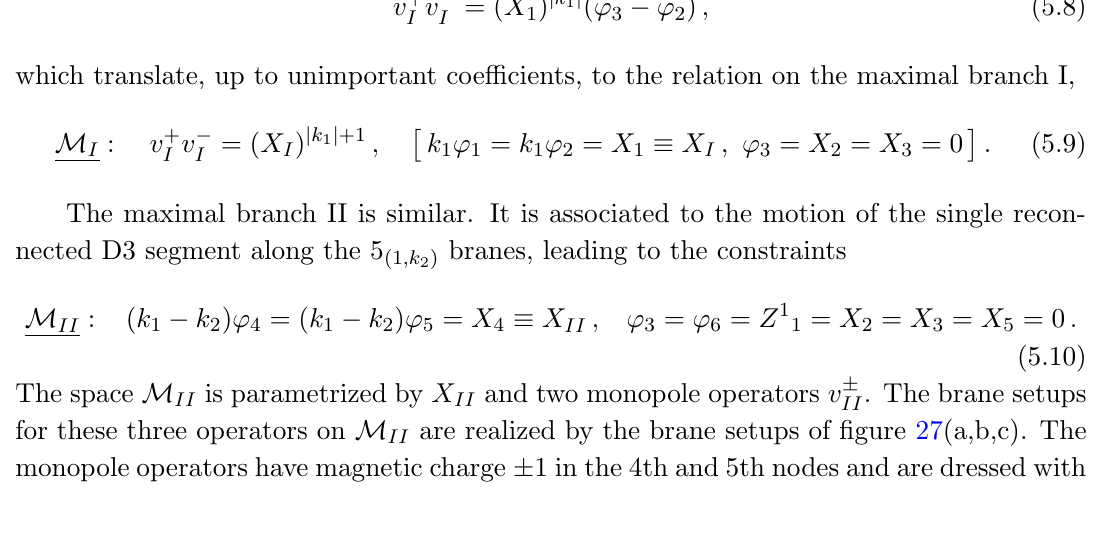
v (cid:0) = ( X I ) j k 1 j +1 . Only the relevant part of the brane setup is I I